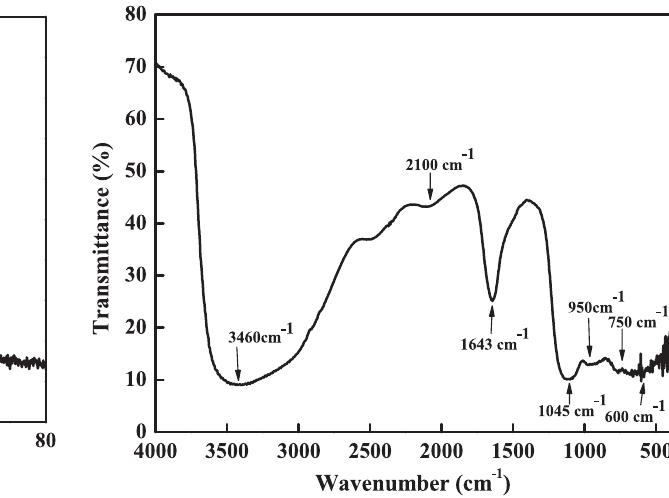
Fig. 3: FT-IR spectrum of the particles shown in Fig. 1A